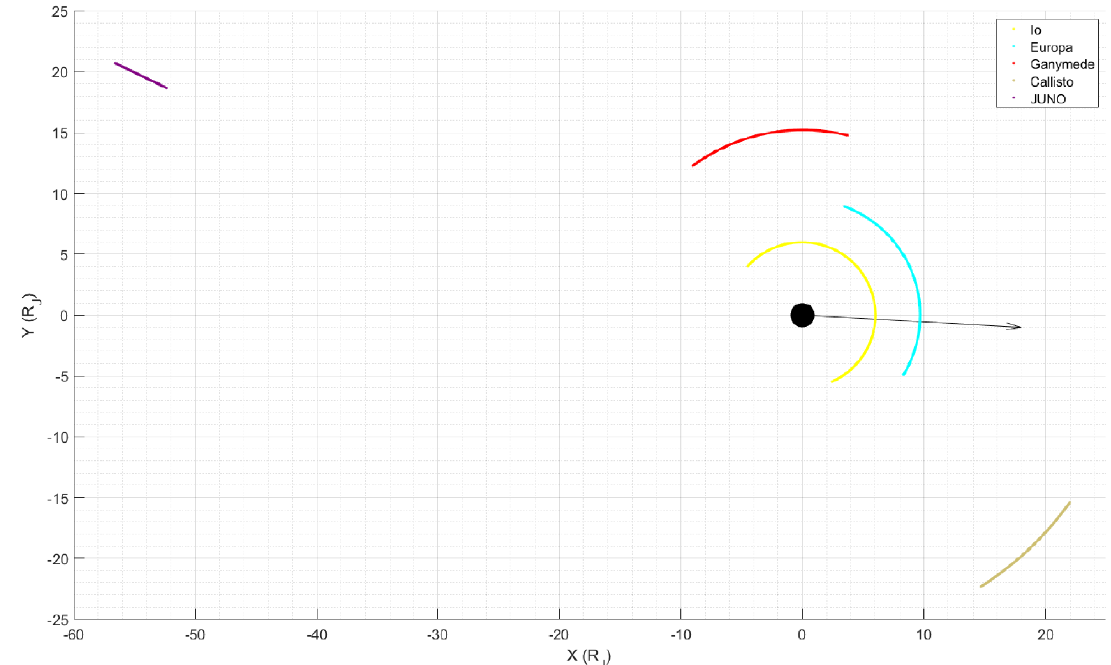
Figure A1. X-Y Positions of Juno, Jupiter, and its four Galilean moons. Units of both axes are the radii of Jupiter. The black sphere is Jupiter and the black arrow is pointing to the balloon-borne telescope, PAST.